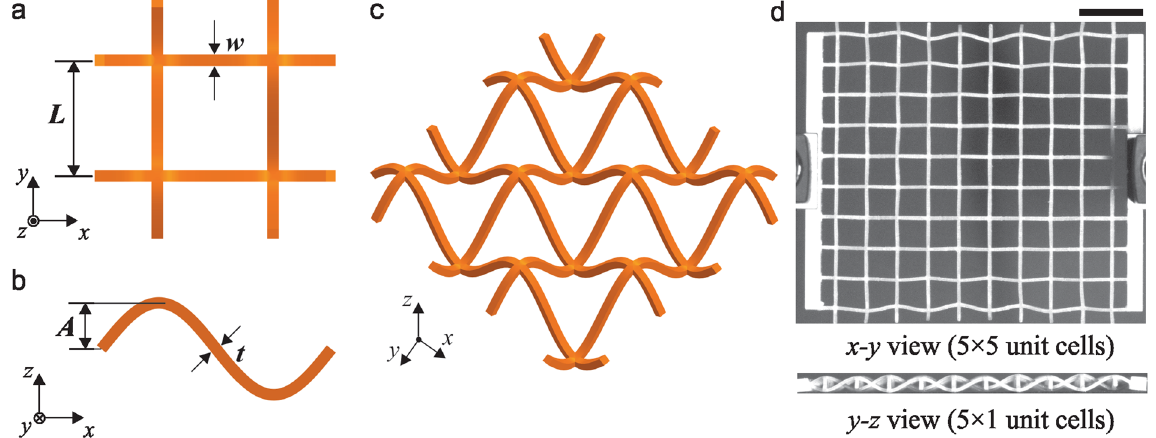
Figure 1. Overview of the proposed 3D planar auxetic metamaterials; ( a ) top and ( b ) side view of a unit cell, ( c ) schematic of the proposed construction, ( d ) photograph of a structure fabricated by 3D printing, comprising 5 × 5 × 1 unit cells in x , y , z coordinates. Scale bar: 2